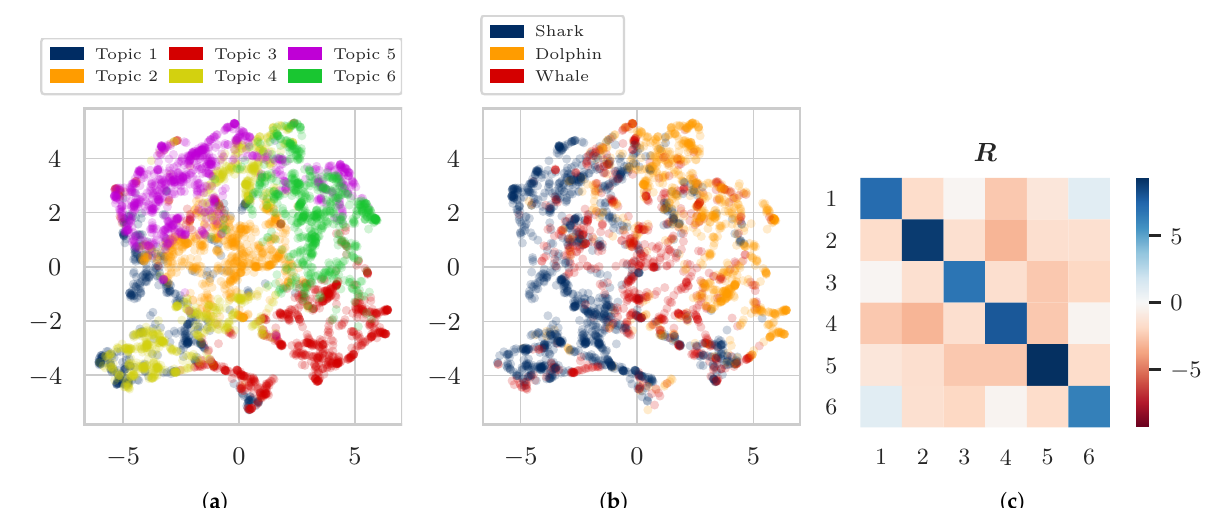
Figure A1. ( a ) 2-dimensional representation of word embeddings A (cid:48) colored by topic assignment. ( b ) 2-dimensional representation of word embeddings A (cid:48) colored by original Wikipedia article assignment (words that occur in more than one article are excluded). ( c ) Colored heatmap of affinity matrix R .